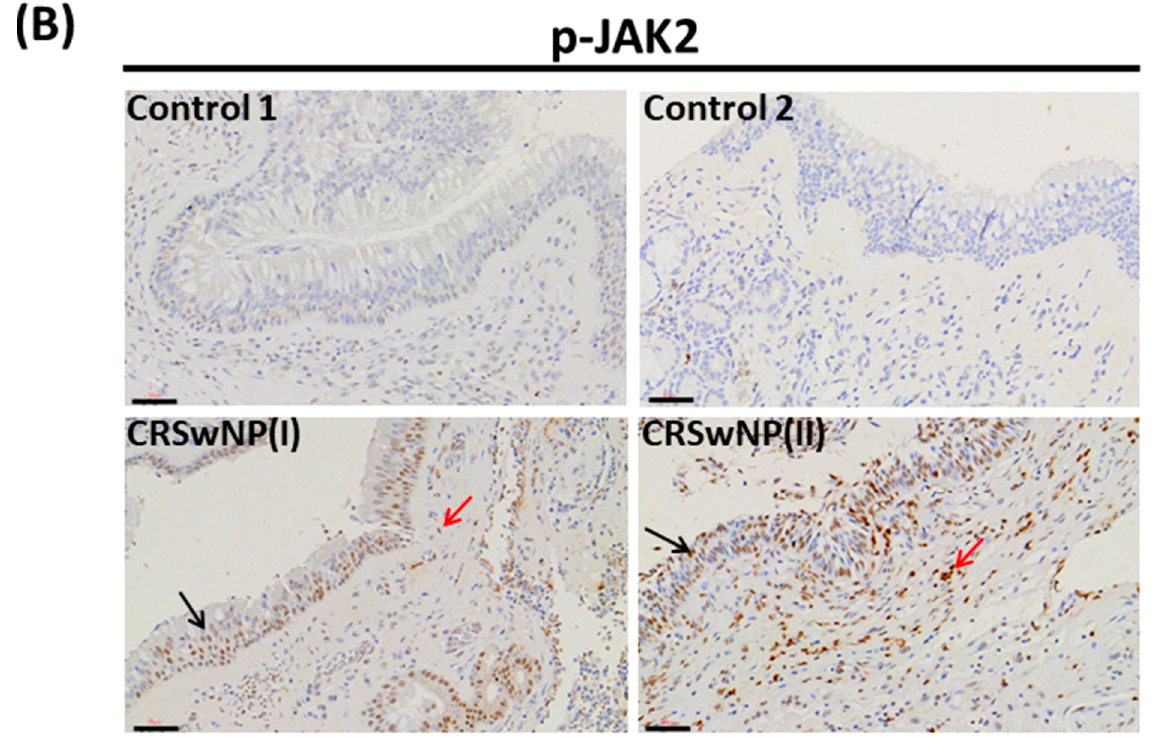
Figure 1. The p ‐ JAK2 expression of the nasal polyp tissues in control 1 ( n = 13), control 2 ( n = 13), CRSwNP(I) ( n = 22), and CRSwNP(II) ( n = 39) groups was analyzed by ( A ) ELISA assay ( B ) immunohistochemistry staining. *** p < 0.01 vs. control 1; # p < 0.05 vs. control 2; ### p < 0.01 vs. control 2; and & p < 0.05 vs. CRSwNP(I) group. Black arrows: epithelial cell staining; and red arrows: inflammatory cells staining. Scale bar = 50 µ m. Table 2. JAK2 ‐ associated cytokines of nasal polyp tissues in control groups and CRSwNP groups.